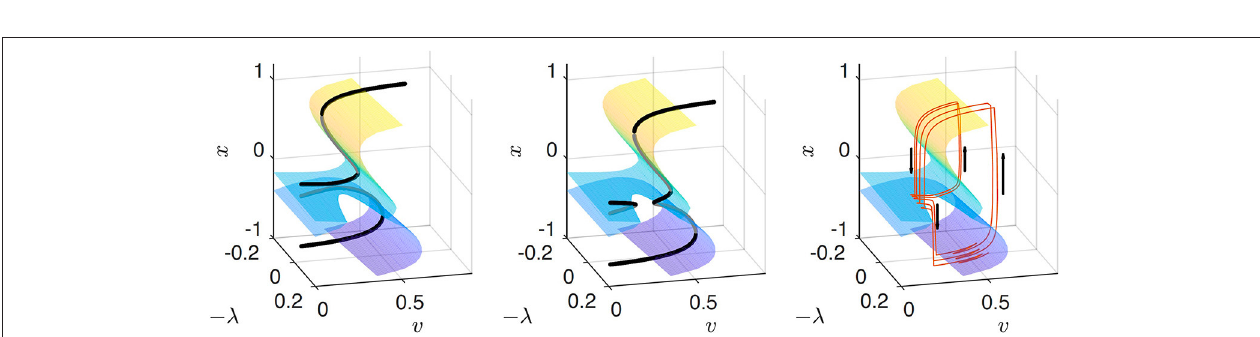
FIGURE 13 | The critical/slow manifold { ( − λ , v , x ) | H ( x , v , λ ) = 0 } is shown in all three panels. The left panel shows the intersections with the plane λ = 0.1 corresponding to the bifurcation diagram in the left panel in Figure 11 , the middle panel shows the intersections with the plane λ = − 0.05 corresponding to the bifurcation diagram in the right panel in Figure 11 . The right panel shows the trajectory of a few glacial cycles as the period of the cycle increases abruptly at the MPT with a slow change of λ .